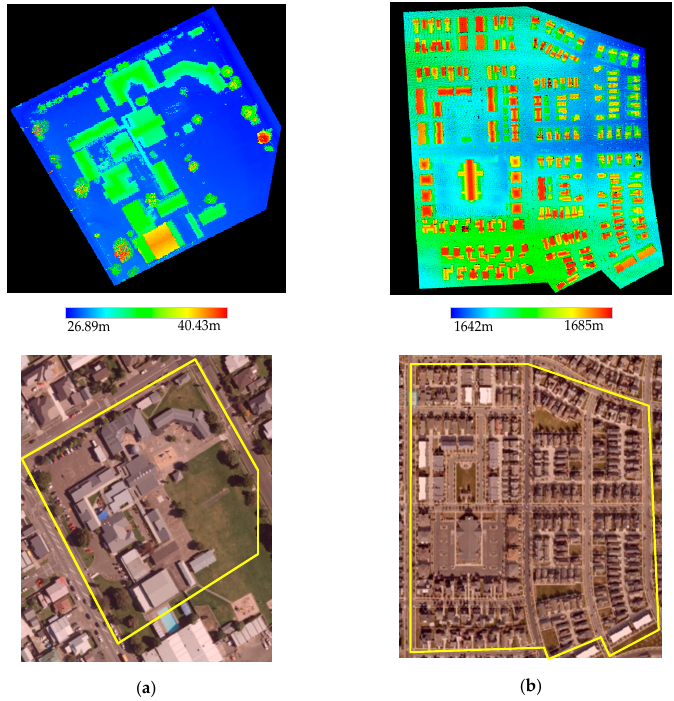
Figure 12. Test datasets. ( a ) New Zealand dataset; ( b ) Utah dataset.